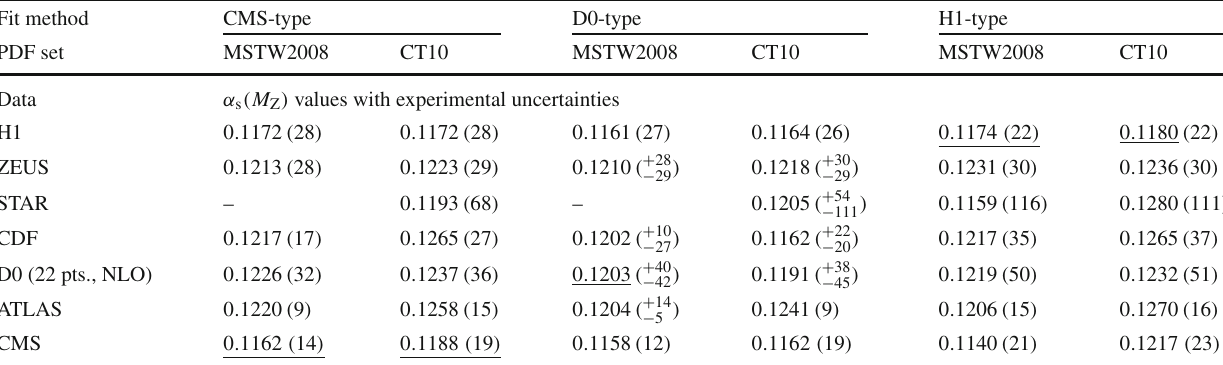
linedvaluescanbedirectlycomparedwiththeresultspublishedinRefs. [27,61,62]. Some fits to the STAR data do not exhibit a local minimum, in which case no value is